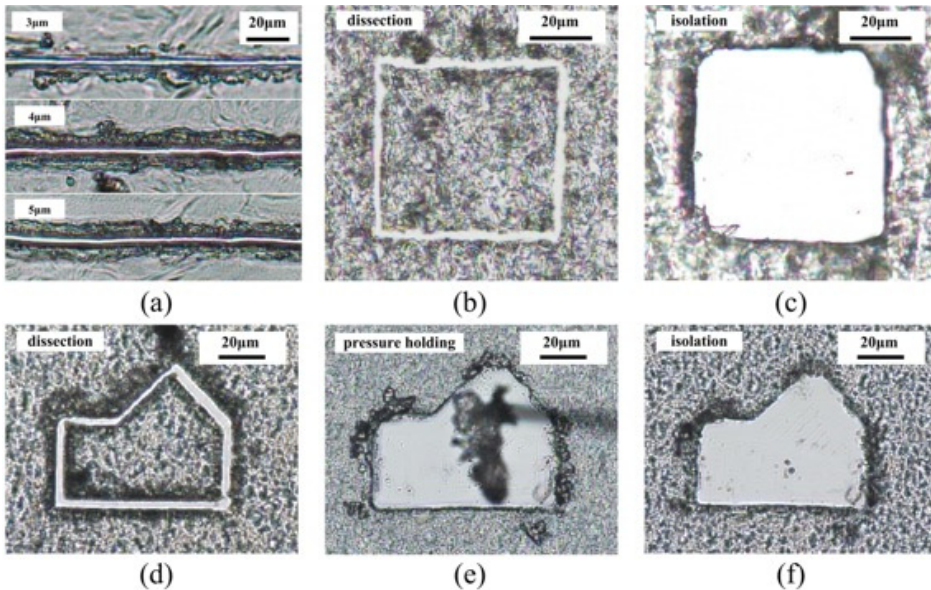
Figure 11. Experimental results of microdissection of different thicknesses and different tissues: ( a ) Different thickness of rat bone tissue sections; ( b ) square area dissecting of rat lung slices; ( c ) isolation of dissecting area of rat lung slices; ( d ) polygonal area dissecting of rat liver slices; ( e ) negative pressure holding isolated tissue; ( f ) isolation of dissecting area of rat liver slices.